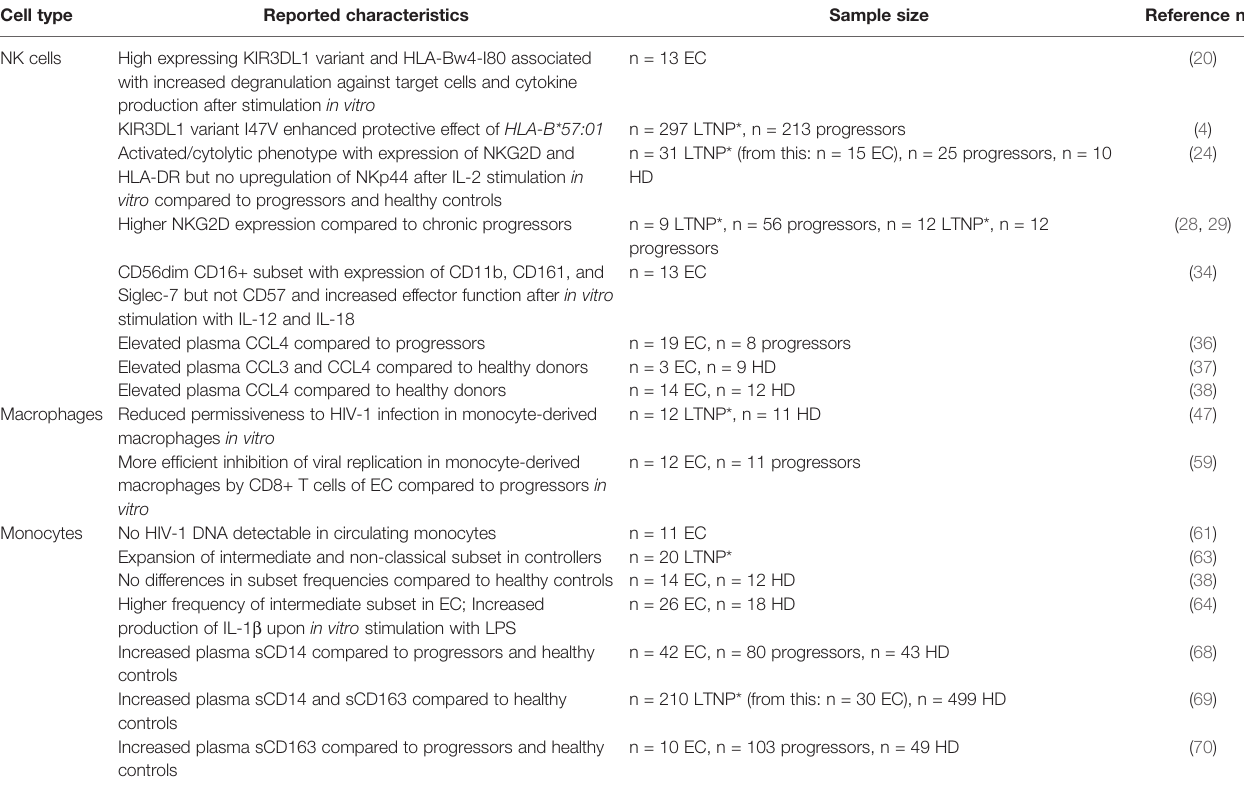
TABLE 1 | NK cell and monocyte/macrophage characteristics associated with HIV-1 control. Cell type Reported characteristics Sample size Reference